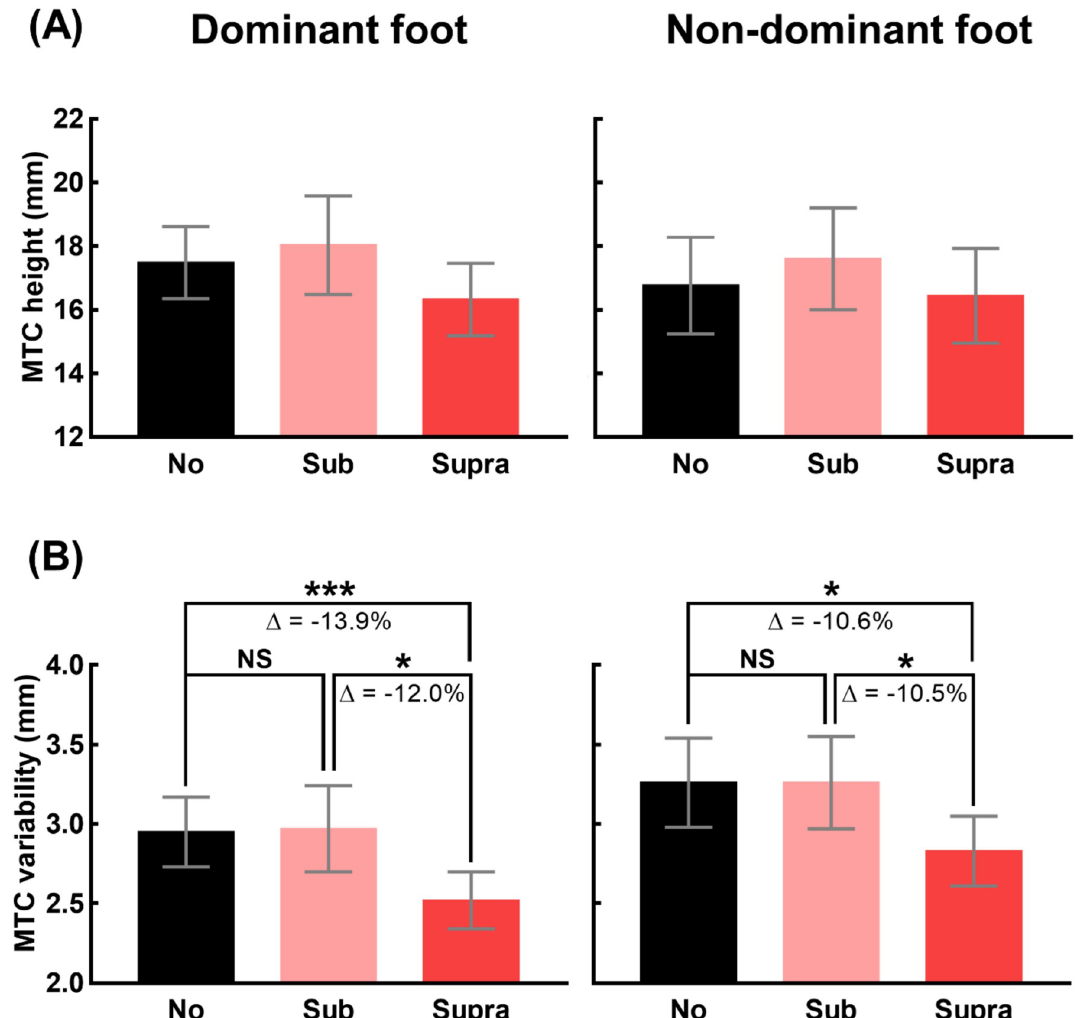
Fig 3. Changes in MTC distribution due to vibrations. (A) and (B) show the means and standard error bars of the values of MTC height and variability of 17 participants, respectively, for the three vibration levels (No: no vibration, Sub: sub-threshold vibration, and Supra: supra-threshold vibration) and both feet. The triple and single asterisk indicate statistically significant difference; ��� : p < 0.001, and � :p < 0.05, whereas NS indicates no statistically significant difference. The reduction in the variability with statistical significance is quantified as Δ (%), which is the ratio of the difference to the larger